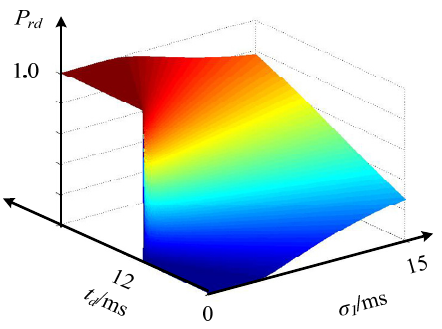
Figure 13. Refuse-operation probability considering consistent delay distribution.